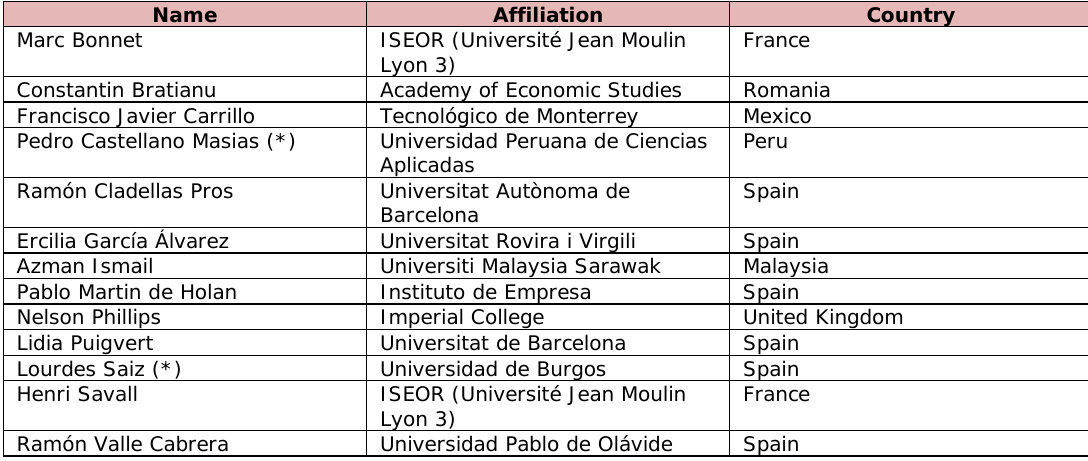
Table 6. “List of members of JIEM editorial board in 2009 (Management, Organizational Behavior and Human Resources). Members added in 2009 are marked with asterisk”.